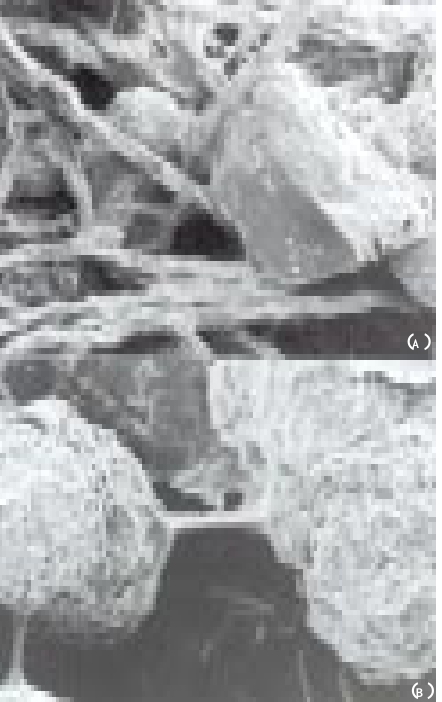
Figura 2. Fotomicrografias em MEV, ilustrando aspectos da interação biota/saprolito nas crostas de P5. A) Cianobactérias filamentosas envolvendo grãos de quartzo e agregados organoargilosos com abundante muco polissacarídeo (200X); B) Agregados minerais subesféricos ligados por exsudatos de polissacarídeos, com importante papel na sua estabilidade